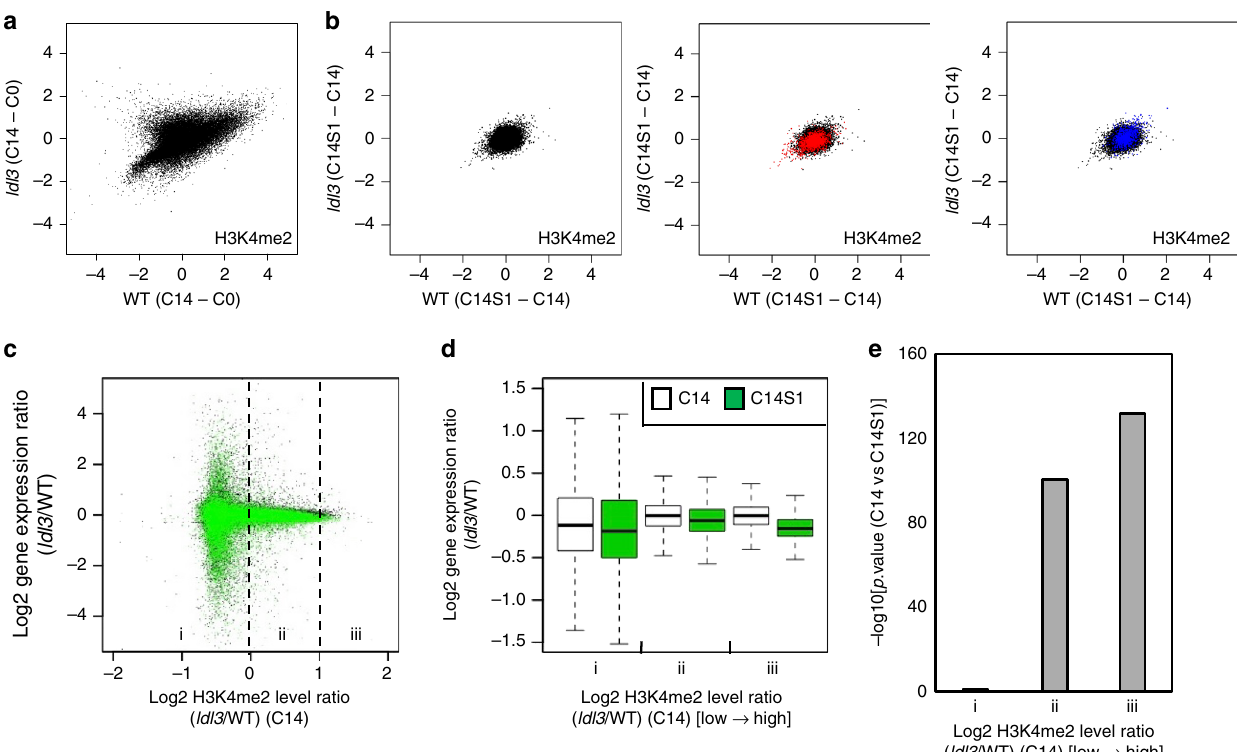
Fig. 5 LDL3-mediated H3K4me2 in CIM regulates gene expression on SIM. a H3K4me2 changes during callus formation (C14 – C0) in ldl3 compared with WT. b H3K4me2 changes upon shoot induction (C14S1 – C14) in ldl3 compared with WT. Each dot represents the square root of RPM. Black dots, all genes; red dots, upregulated genes in C14S1 in WT (UGs_S1); blue dots, downregulated genes in C14S1 in WT (DGs_S1). c Altered gene expression in ldl3